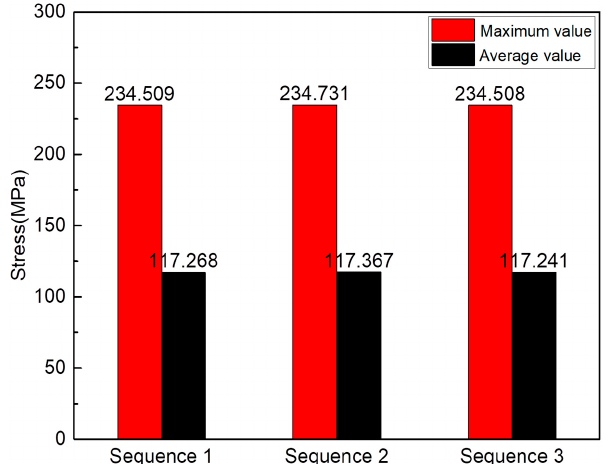
Figure 19. Comparison of the von Mises stresses according to the black routes (as shown in Figure 18) in three different sequences (the red histograms represent the maximum stresses, and the black ones represent the average stresses).